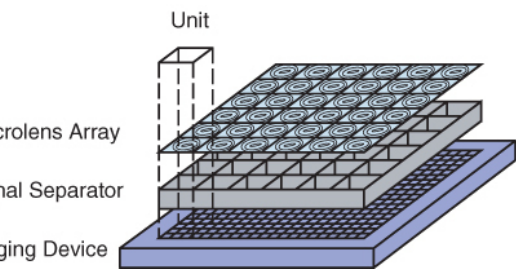
Figure 3. The structure of the TOMBO system. Reprinted with permission from [28] © The Optical Society.